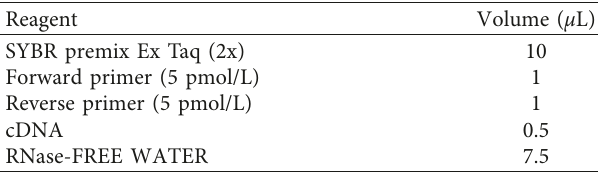
Table 2: RT-qPCR reaction system (20 μ L). Table 1: Primer